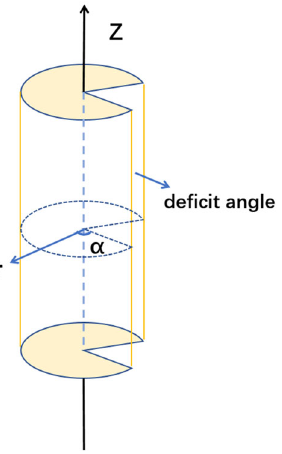
Fig. 1 Schematic representation of the cosmic string spacetime with an infinite and straight cosmic string along z direction